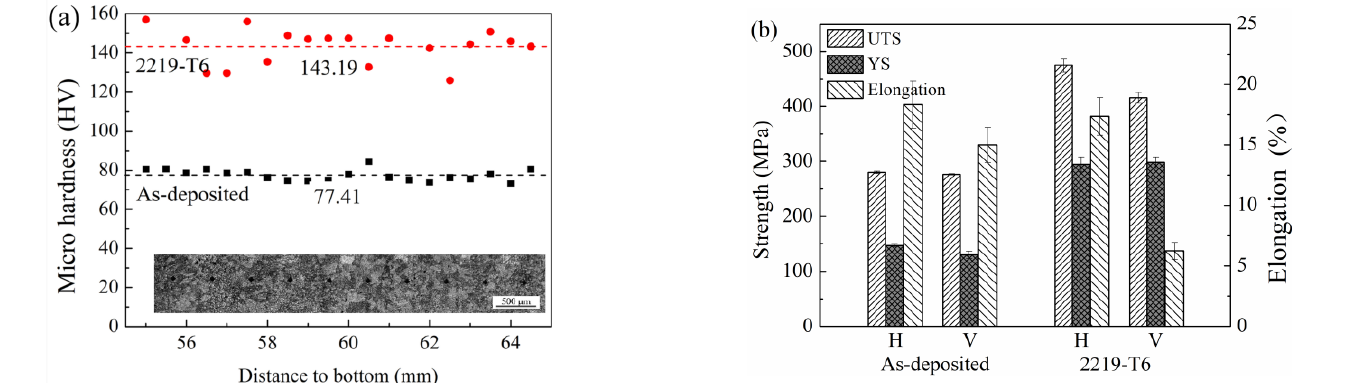
Figure 3. ( a ) The micro hardness distribution and ( b ) tensile properties for the as-deposited and heat-treated WAAM 2219 alloy.